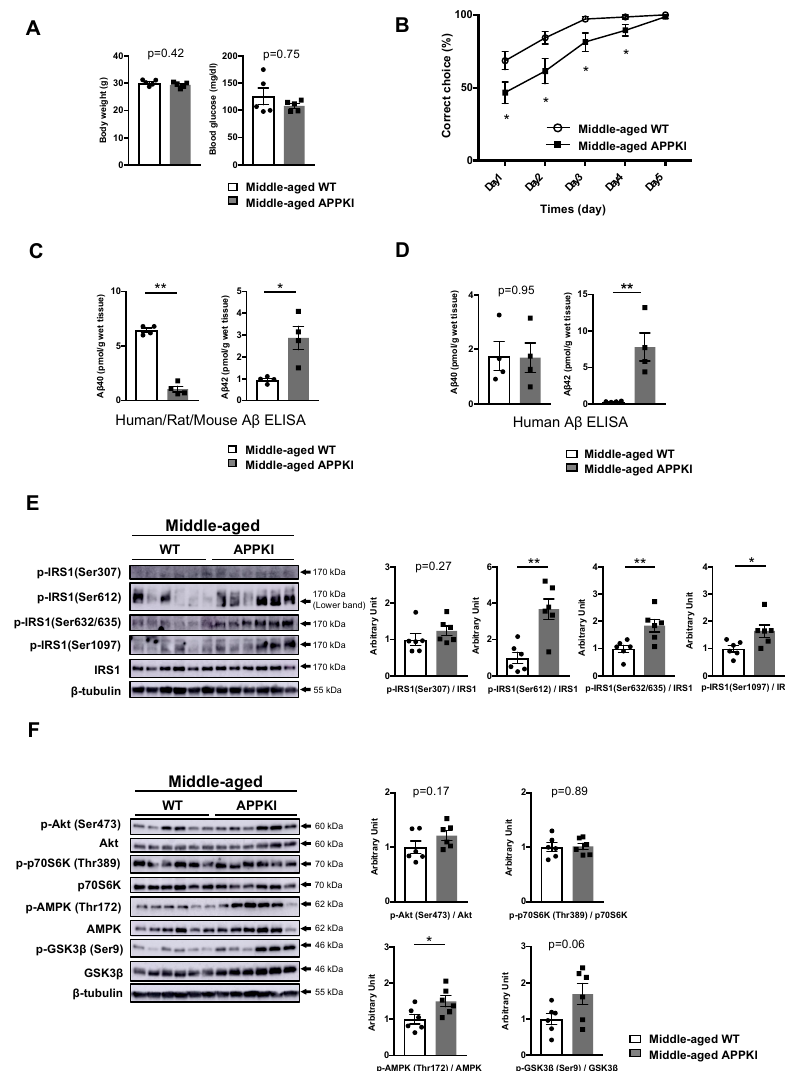
Figure 5. Memory decline accompanied by sustained phosphorylation of IRS1 Ser residues in the hippocampus of middle-aged APPKI NL-G-F mice. ( A ) The graphs of body weight and blood glucose levels in middle-aged wild-type (WT) and APPKI NL-G-F mice (34–36 weeks of age, n = 5 mice per group). ( B ) Evaluation of learning memory function in middle-aged WT (n = 14) and APPKI NL-G-F mice (n = 15 mice per group) using the water T-maze test. ( C ) Quantitative analysis of T-PER-extractable A β 40 and A β 42 levels in the hippocampi of middle-aged WT and APPKI NL-G-F mice using the human / rat / mouse β amyloid (1–40 and 1–42) ELISA (34–36 weeks of age, n = 4 biologically independent samples per group). ( D ) Quantitative analysis of T-PER-extractable A β 40 and A β 42 levels in the hippocampi of middle-aged WT and APPKI NL-G-F mice using the human β amyloid (1–40 and 1–42) ELISA (34–36 weeks of age, n = 4 biologically independent samples per group). ( E ) Western blot analysis of phosphorylated insulin receptor substrates 1 mouse Ser307 [p-IRS1 (mSer307)], p-IRS1 (mSer612), p-IRS1 (mSer632 / 635), p-IRS1 (mSer1097), IRS1, and ß-tubulin in the hippocampi of middle-aged WT and APPKI NL-G-F mice (34–36 weeks of age, n = 6 biologically independent samples per group). Arrow indicates the p-IRS1 mSer612 -corresponding band (lower band) in ( E ). Quantitative analysis of the phosphorylation of IRS1 at mSer307, mSer612, mSer632 / 635, and mSer1097 normalized to total protein. ( F ) Western blot analysis of phosphorylation levels of Akt Ser473, p70S6K Thr389, AMPK Thr172, and GSK3 β Ser9 as well as total protein levels of Akt, p70S6K, AMPK, GSK3 β , and ß-tubulin in the hippocampi of middle-aged WT and APPKI NL-G-F mice (34–36 weeks of age, n = 6 biologically independent samples per group). Quantitative analysis of the phosphorylation of Akt Ser473, p70S6K Thr389, AMPK Thr172, and GSK3 β Ser9 normalized to the respective total protein contents. Results are presented as mean ± SEM, * p < 0.05; ** p <